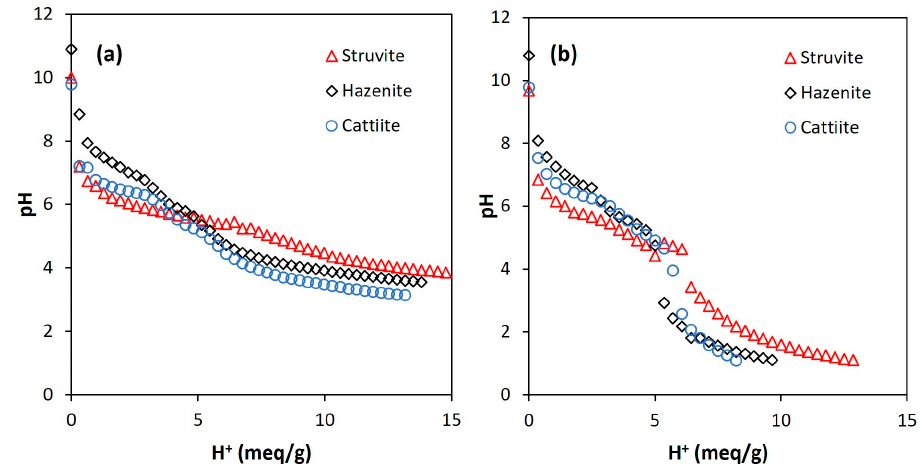
Figure 1. Titration curves for the acid dissolution of the MgP salts (struvite, hazenite and cattiite) using citric acid ( a ) and nitric acid ( b ). Dilution ratio: 28 g salt per liter of water.